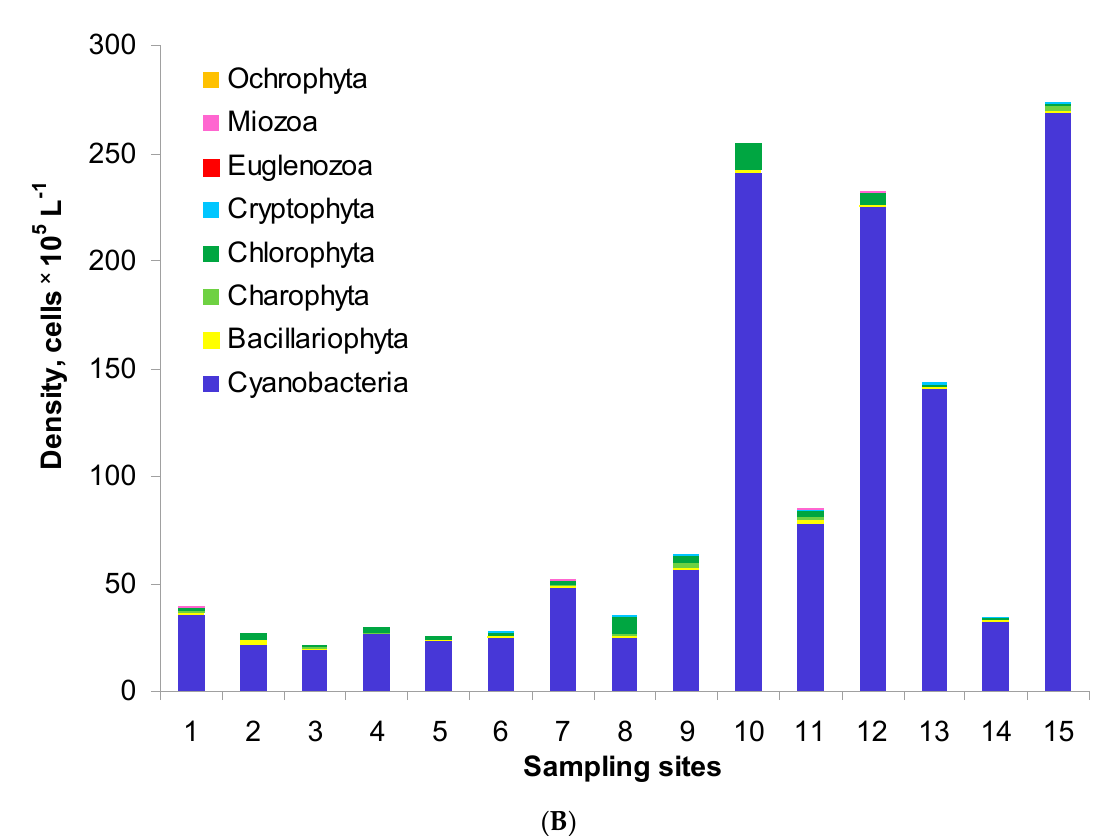
Figure 2. Phytoplankton density and structure in the post-flood period ( A ) and the pre-flood period ( B ) in the main channel of Lake Nasser; sampling sites 1–15 concern five sectors and their eastern, middle and western parts, with detailed information in Table 1. Table 5. Species richness and biodiversity of phytoplankton in Lake Nasser in the post-flood and pre-flood